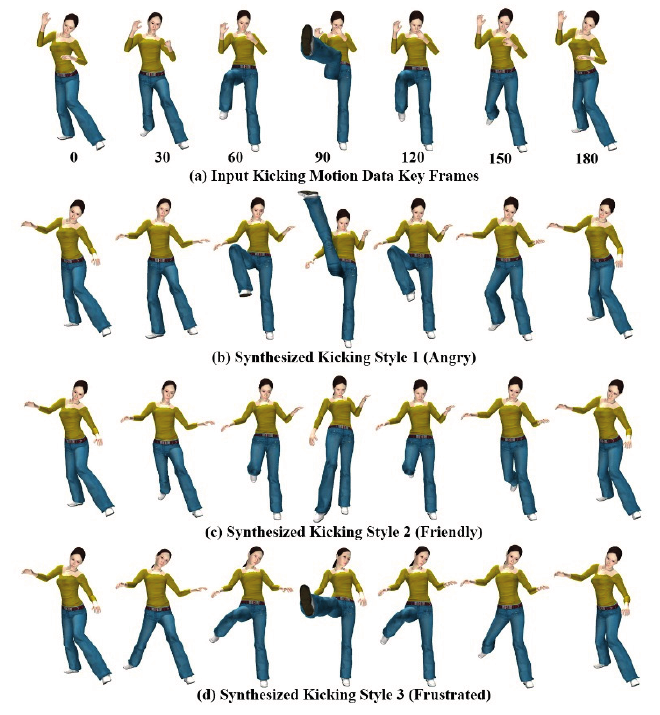
Figure 9. Kicking motions of avatar.